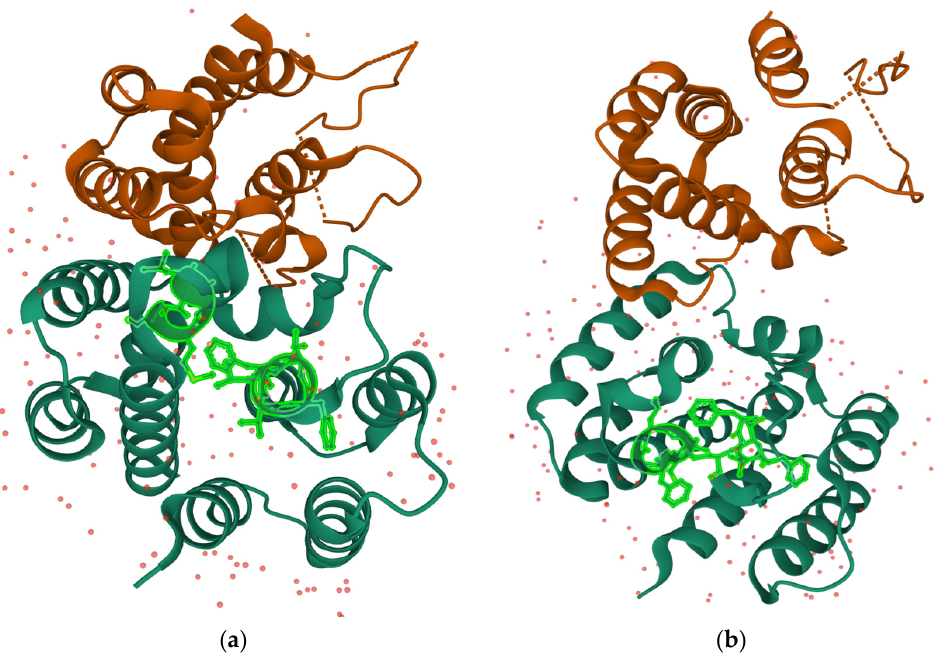
Figure 4. ( a ) The best predicted primary contact in the native structure of M1 [75]; ( b ) the second-best predicted contact is also represented. The side chains of the amino acids included in the contact-defining segments are represented. The structure is a dimer, and the primary contact has been represented only on a single chain for clarity. The pink dots are oxygen atoms of water molecules included in the crystal structure.